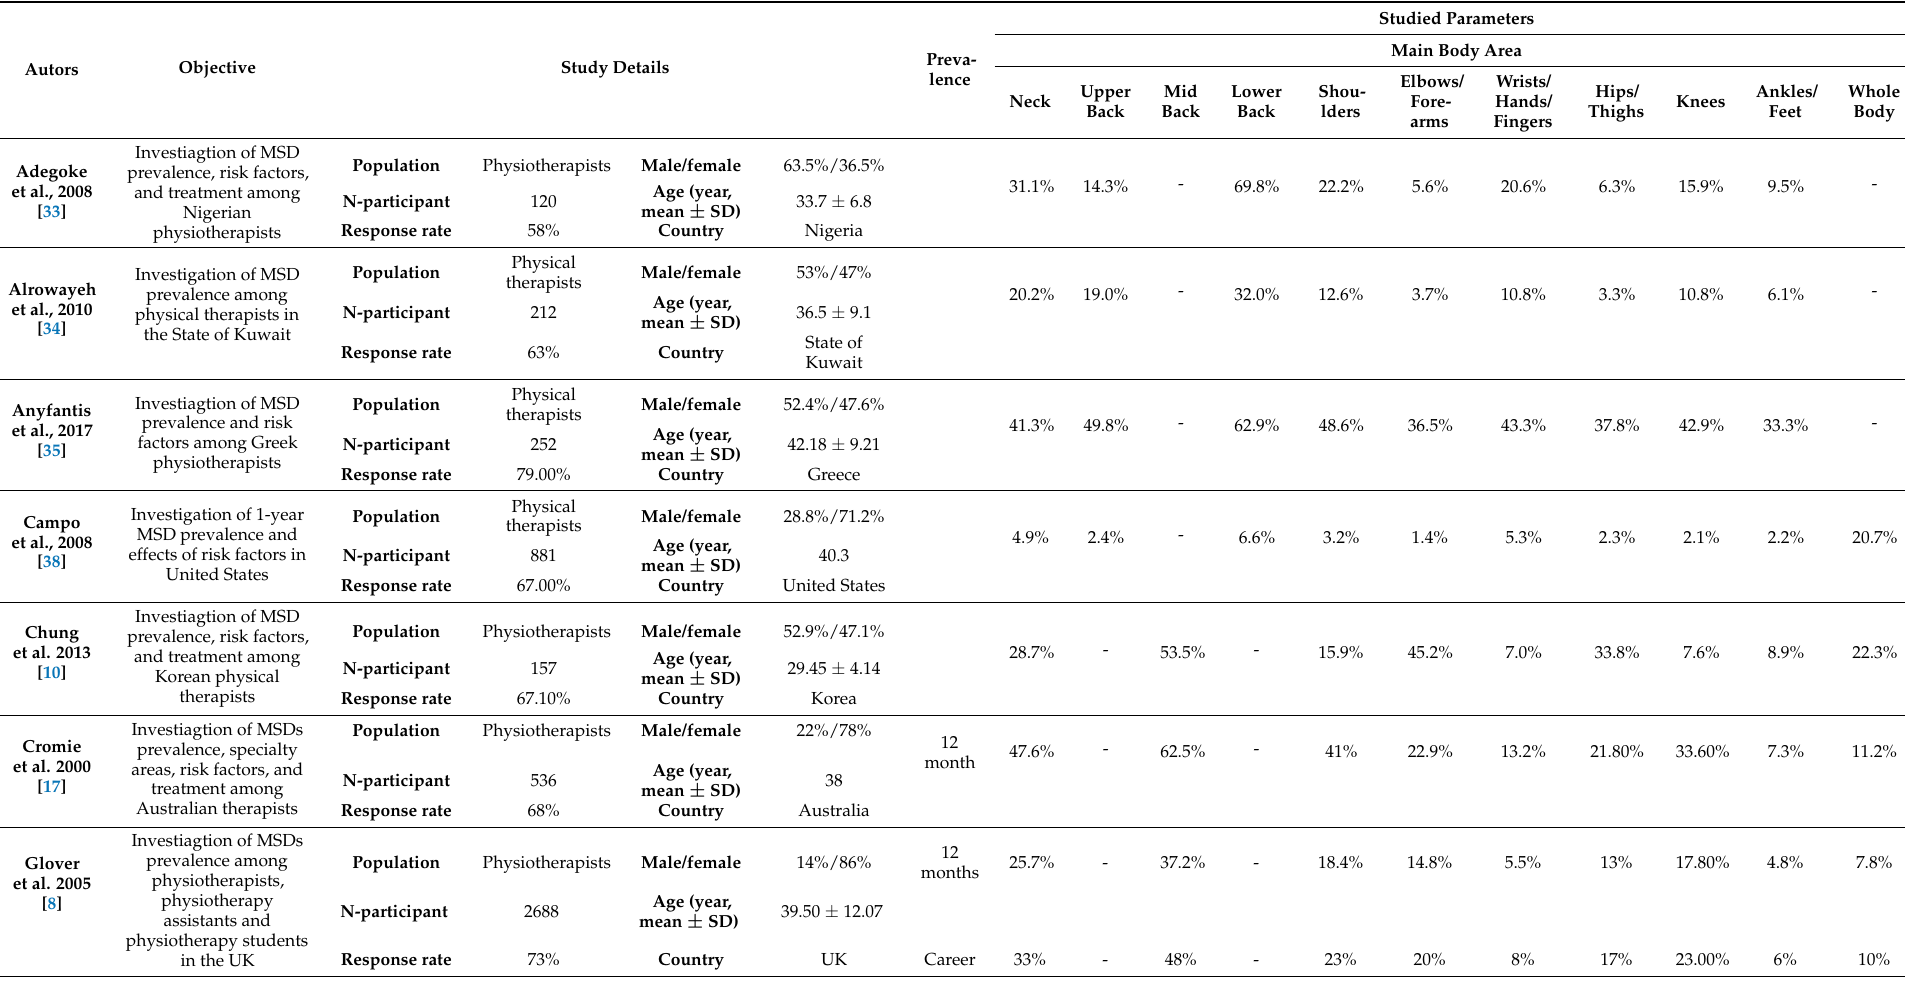
Table 2. Objectives and characteristics of the 36 included studies by healthcare profession. MSD prevalence by body area was reported for each study (when